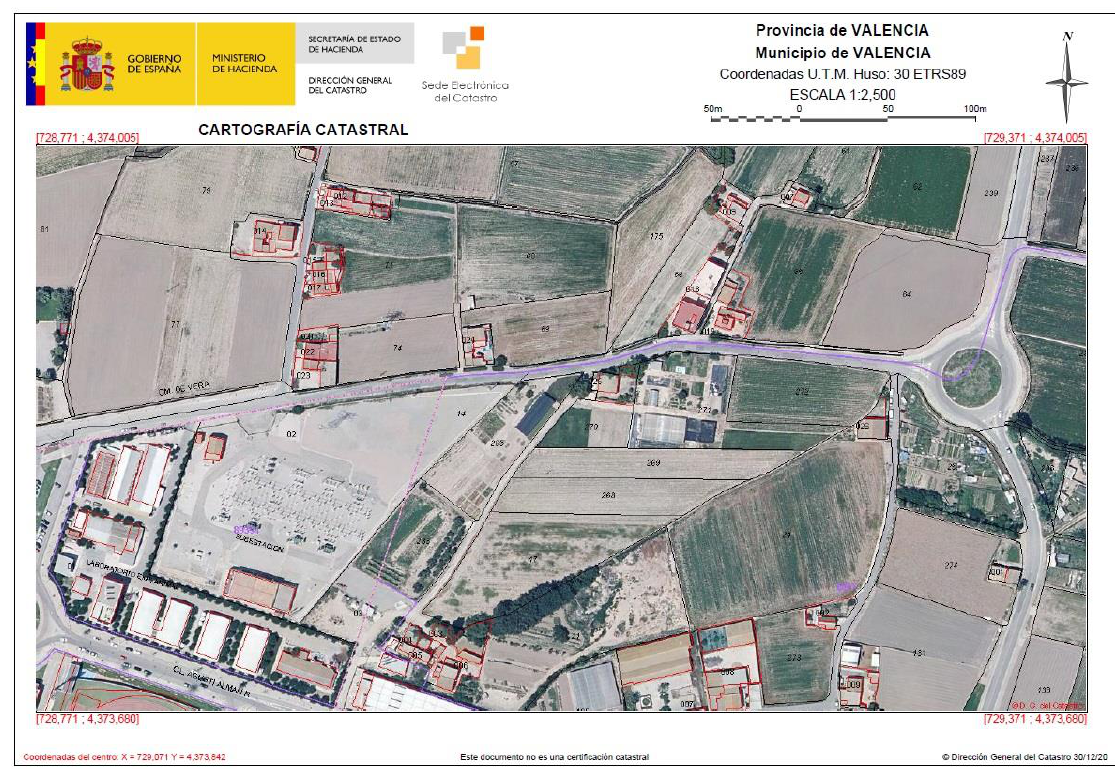
Figure 1. Catastral map for printing available from the Electronic Office of the Cadastre (SEC), and based on an orthophoto from the Aerial Orthophotography National Plan (PNOA). Source: Directorate General for Cadastre